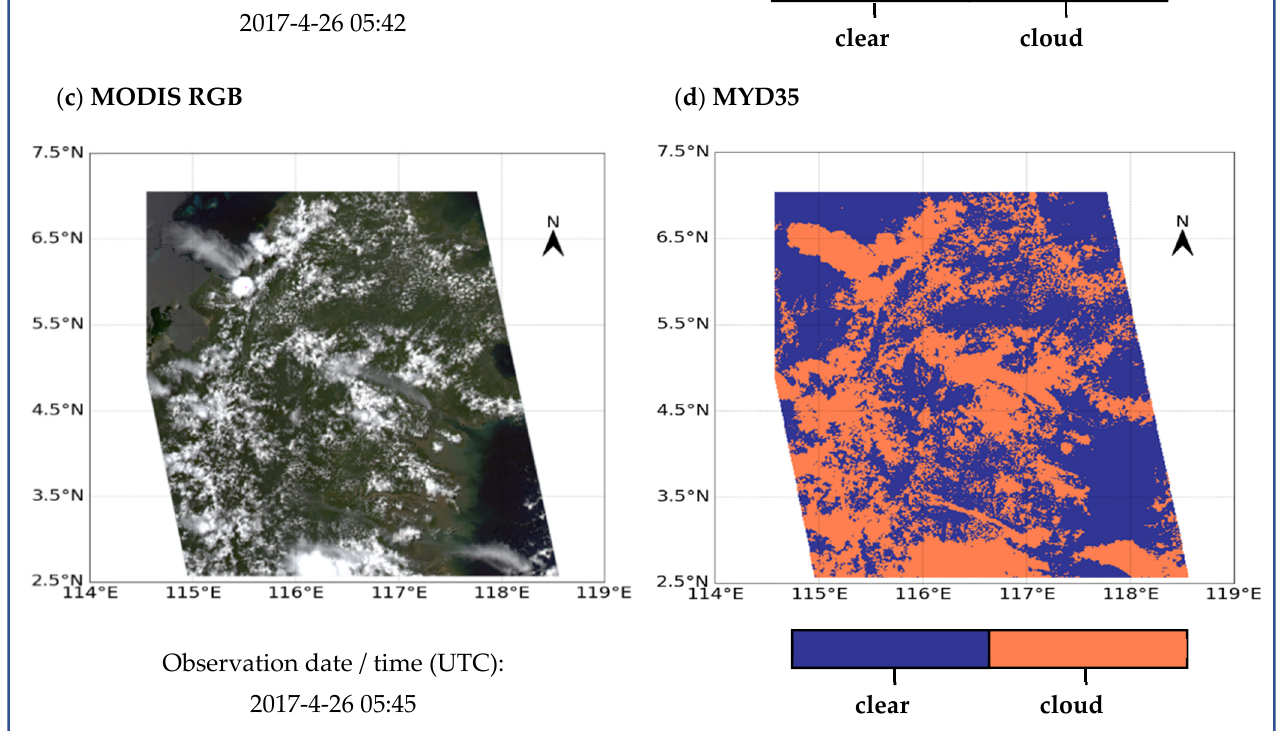
Figure 5. Same as Figure 4, but over the islands of Indonesia at 05:42 UTC 26 April 2017 for CAPI and at 05:45 UTC 26 April 2017 for MODIS.